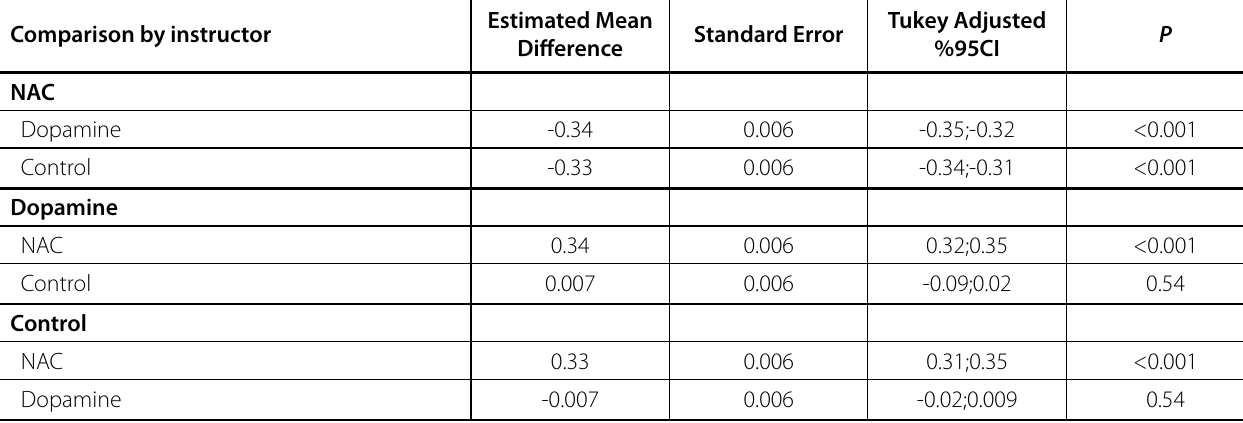
Table 8 . Postoperative day 2. Post-hoc evaluation of creatinine with Tukey HSD. Comparison by